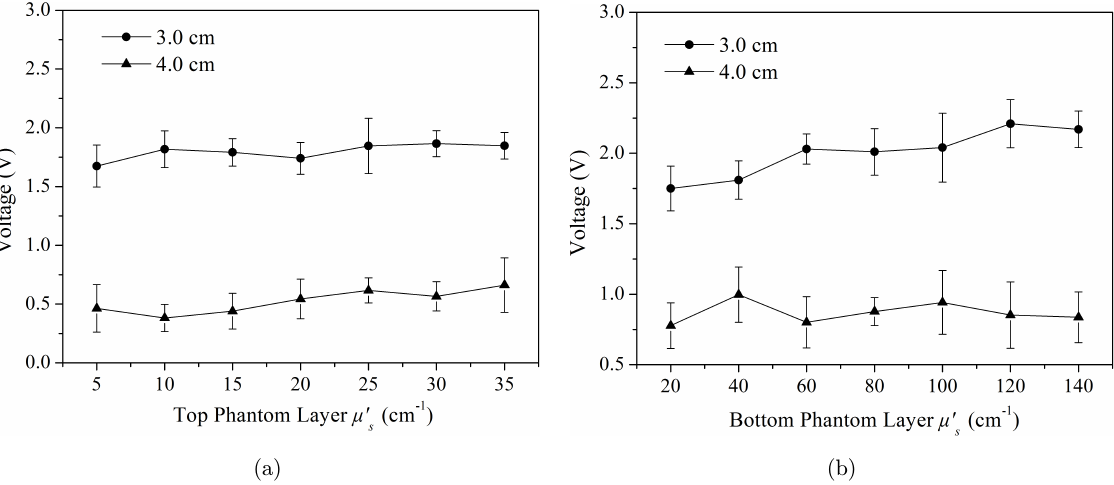
Fig. 9. Relationships of the voltage and (cid:1) 0 s of phantom layer. (a) Curves of the voltage and (cid:1) 0 s of top phantom layer and (b) curves of the voltage and (cid:1) 0 s of bottom phantom layer.